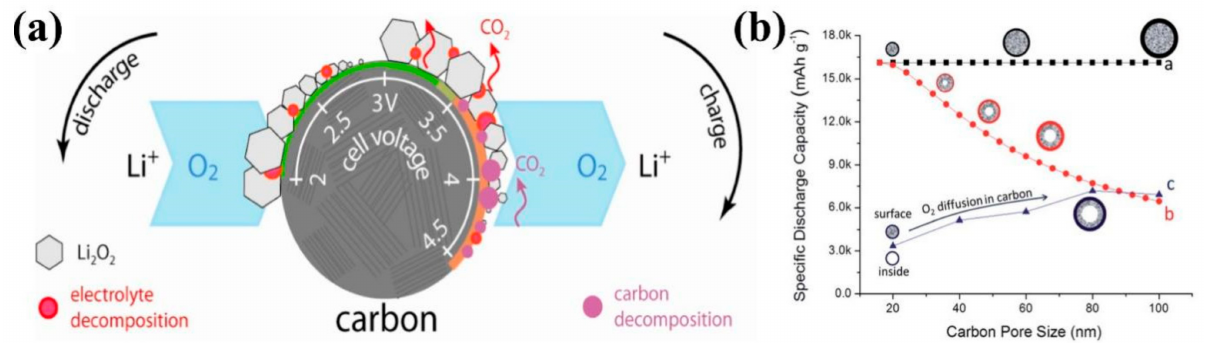
Figure 2. ( a ) Scheme for the decomposition of carbon electrode in LABs. Reprinted with permission from ref. [26]. Copyright 2013 American Chemical Society. ( b ) Physical model of Li 2 O 2 in porous carbon: Line a indicates that all carbon pores are filled with Li 2 O 2 ; Line b assumes that a Li 2 O 2 monolayer (with a thickness of 7.8 nm) is formed in the carbon pores; Line c is the experimental data. Reprinted with permission from ref. [42]. Copyright 2014 Royal Society of